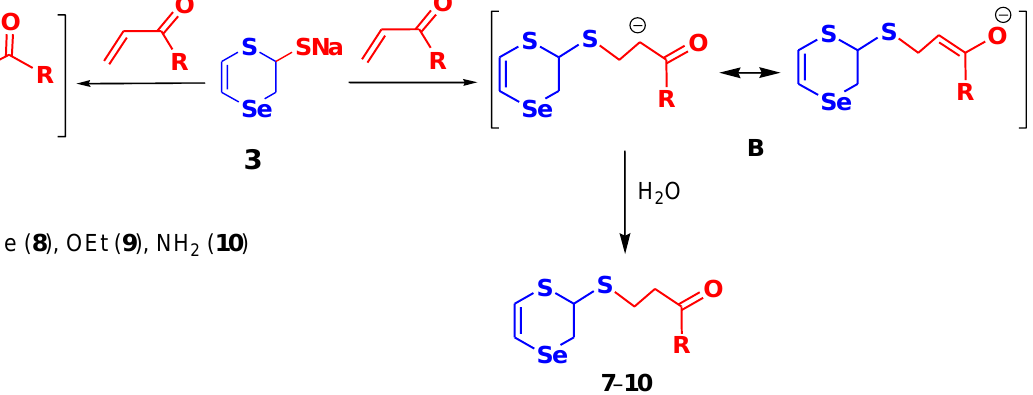
Scheme 6. Explanation of regioselectivity of the nucleophilic addition of sodium dihydro-1,4-thiaselenin-2-ylthiolate 3 to alkenes containing a carbonyl group.